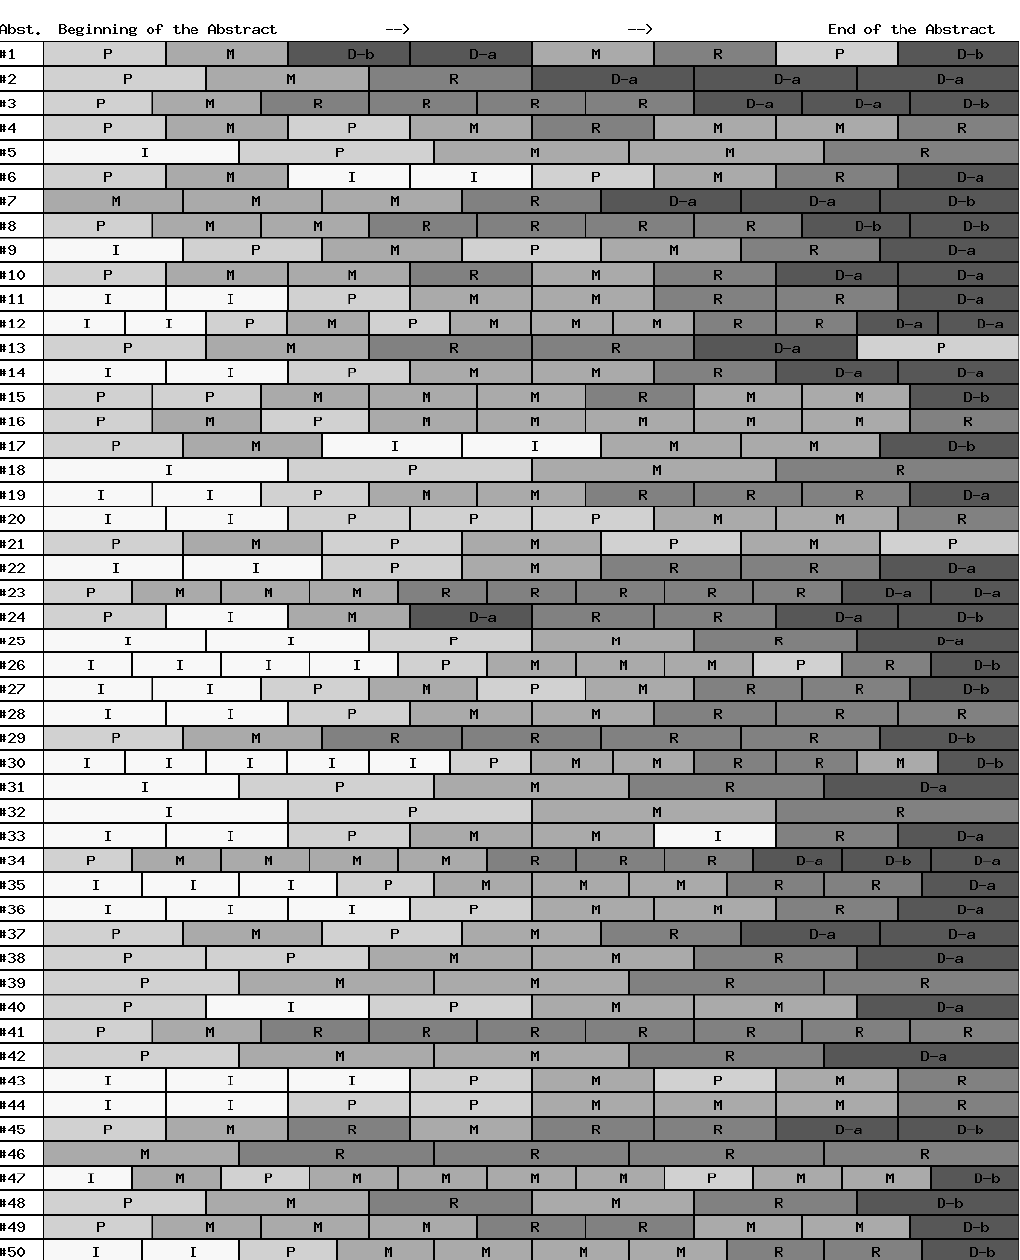
Figure 3. This chart visualizes the data as a whole. Each line represents one of the 50 abstracts examined. As indicated by the arrows at the top, the first rectangle on the left is the first move, and the last rectangle on the right is the last move in the corresponding abstract. Note. This visual was prepared using Perl programming language and its GD Graphics Module Version ‐ 2.56 by Lincoln D. Stein.